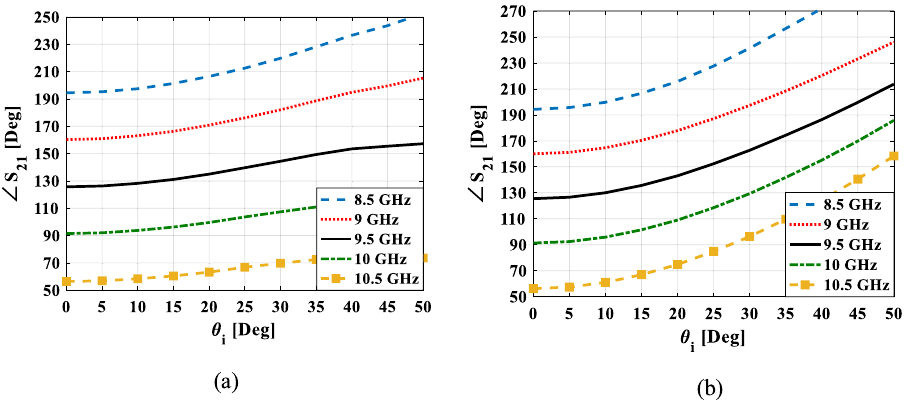
Figure 5. Simulated transmission phase for the unit cell shown in Fig. 3 versus incident angle at five frequencies for ( a ) TE polarization ( b ) TM